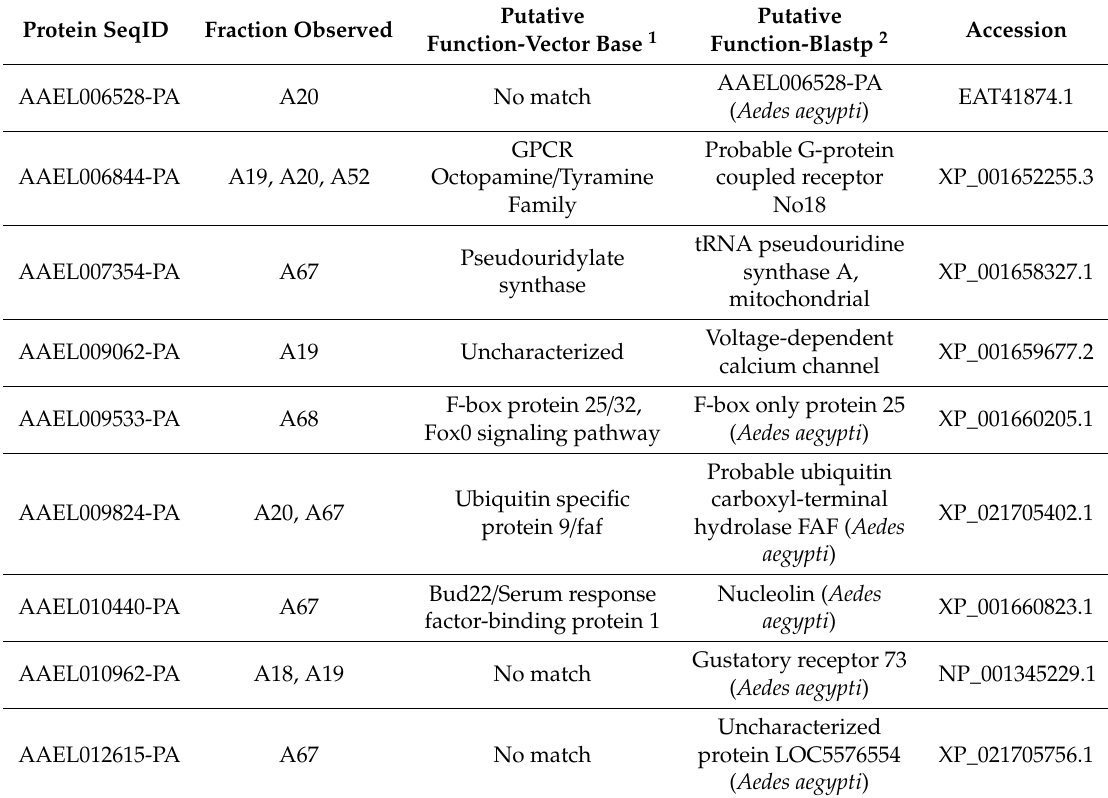
Figure 1. Saliva was collected from female Ae. aegypti after blood feeding. Mosquito saliva was